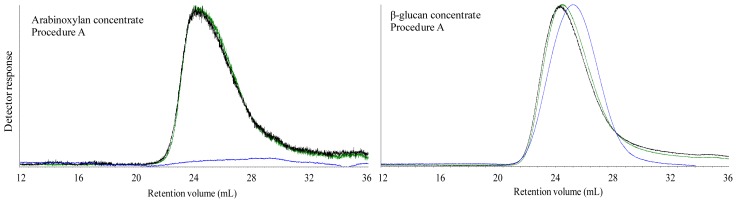
Size exclusion chromatography with RALLS (green), LALLS (black) and intrinsic viscosity (blue) signal of alkaline extracts of fiber concentrates (procedure A).